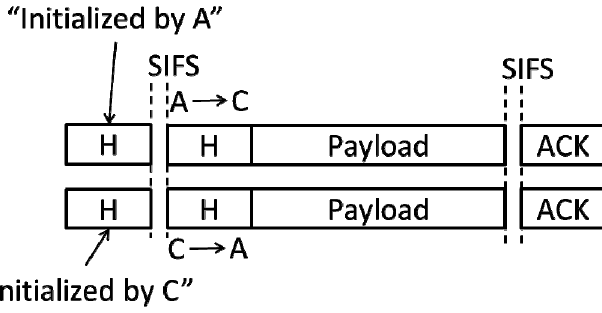
Figure 4. A and C re-conduct an FD communication.